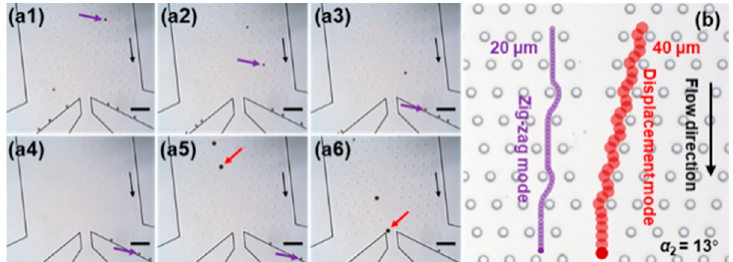
Figure 6. Probability distributions of the magnetic beads at all outlets with the forcing angles of ( a ) 10°, ( b ) 13° and ( c ) 20° when the W in 2 = 2 Dy 2. ( d ) Probability distribution of magnetic beads for different W in 2 at α 2 = 13°.